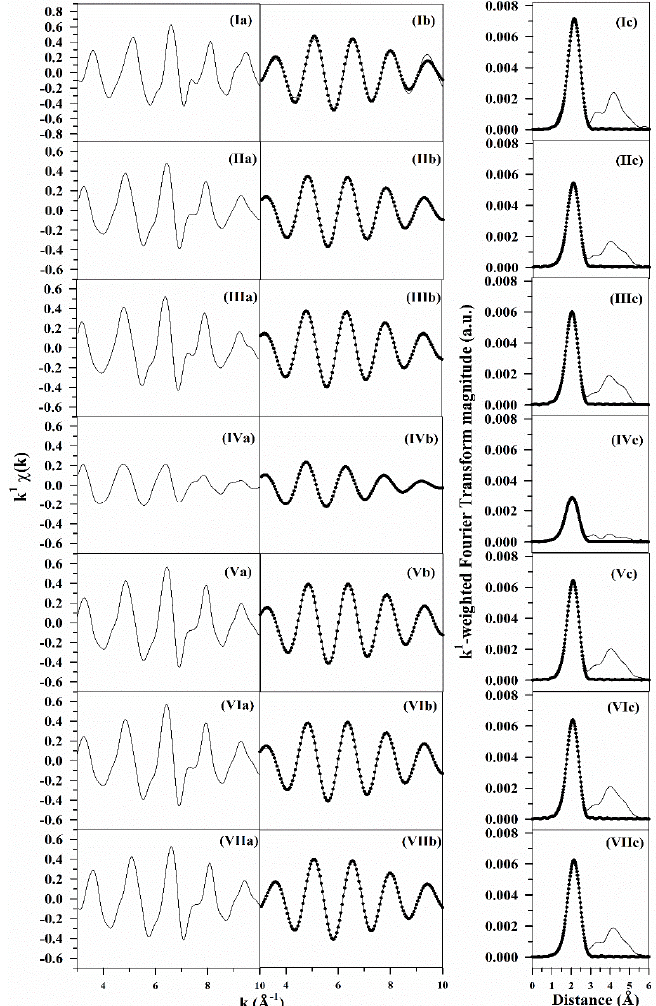
Figure 10. EXAFS fittings after H 2 -TPR and cooling, including ( a ) raw k 1 -weighted χ (k) data, ( b ) (solid line) filtered k 1 -weighted χ (k) data and (filled circles) the results of the fittings, and ( c ) (solid line) raw k 1 -weighted Fourier transform magnitude and (filled circles) the results of the fittings for (I) Co 0 foil (note different scale), (II) calcined 12% Co/SiO 2 from cobalt acetate, (III) uncalcined 12% Co/SiO 2 from cobalt acetate, (IV) III with 0.5% Pt, (V) calcined 12% Co/SiO 2 from cobalt chloride, (VI) uncalcined 12% Co/SiO 2 from cobalt chloride, and (VII) VI with 0.5% Pt. The catalysts were treated at up to 600 °C in hydrogen.